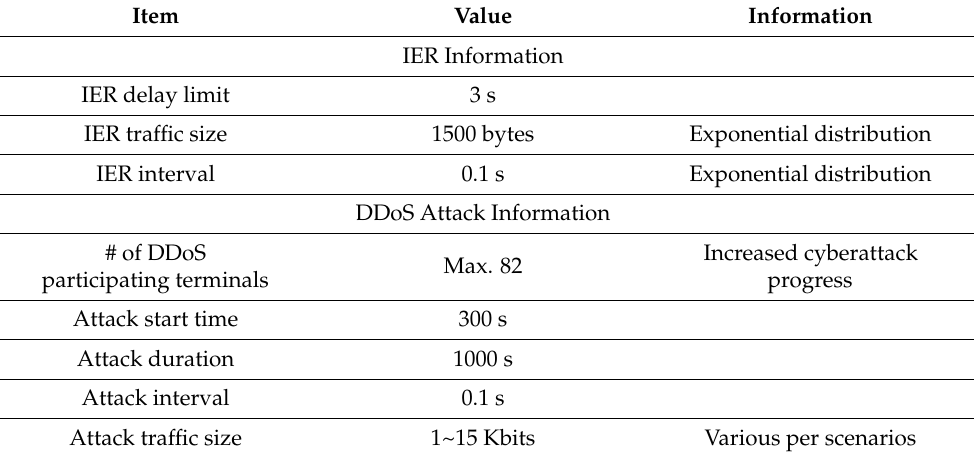
Table 2. Experiment Characteristics.